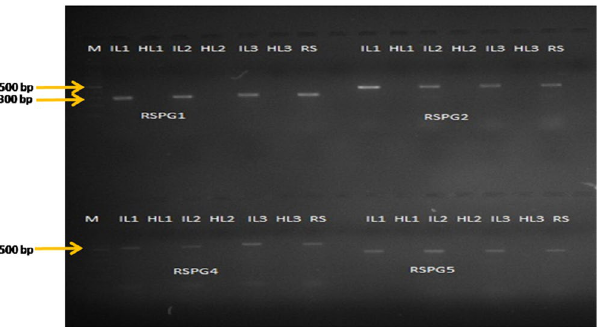
Figure 2. Validation of primer sets of polygalacturonase gene as a diagnostic marker for R. solani AG-1 IA isolate AG1L1 (genomic DNA isolated from diseased plant samples). RSPG1 (300 bp), RSPG2 (375 bp), RSPG4 (500 bp) and RSPG5 (336 bp) show distinct amplification bands in case of tissue sheaths infected with R. solani AG-1 IA whereas no amplification is observed in healthy tissues. IL infected leaf, HL healthy leaf, and RS R. solani strains.